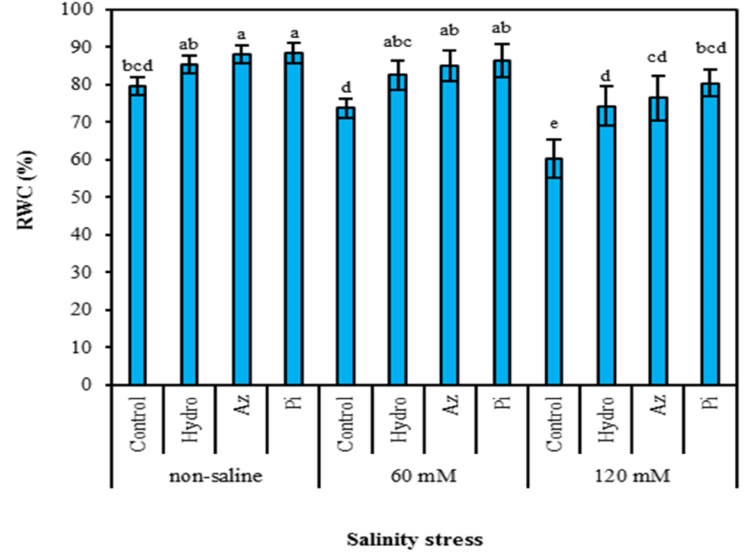
Figure 1. Effect of seed priming on relative water content (RWC) of milk thistle leaves under different levels of salinity. The same letter within each column indicates no significant difference among treatments ( p ≤ 0.05) using New Duncan’s test. Values mean of four replicates ± SD. Hydro: hydro- priming, Az: Azotobacter chroococcum and Pi: Piriformospora indica